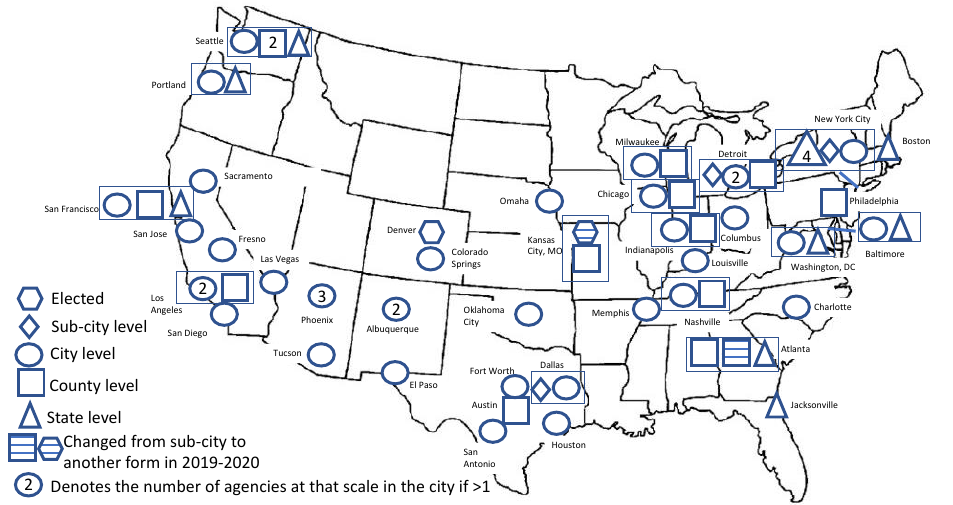
Figure 1. Public Transit Governance Structures by Level of Control.